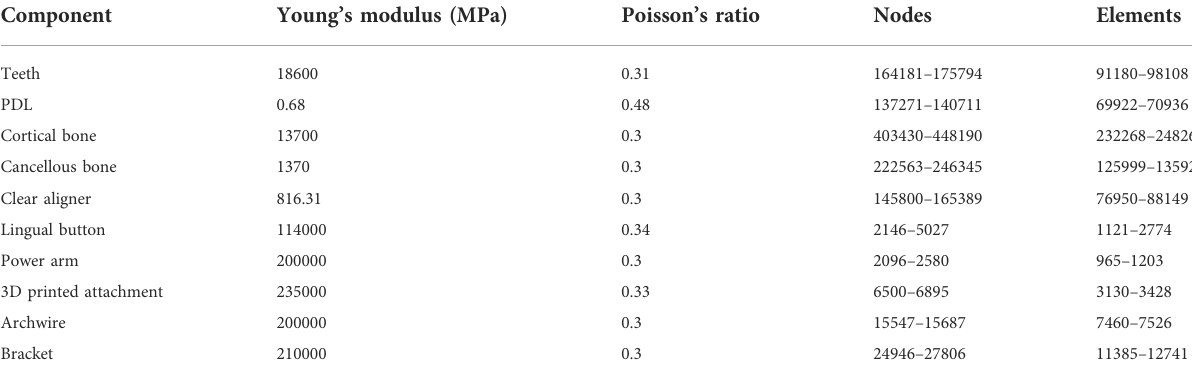
TABLE 1 Material properties and number of nodes and elements of the components of the fi nite element model.